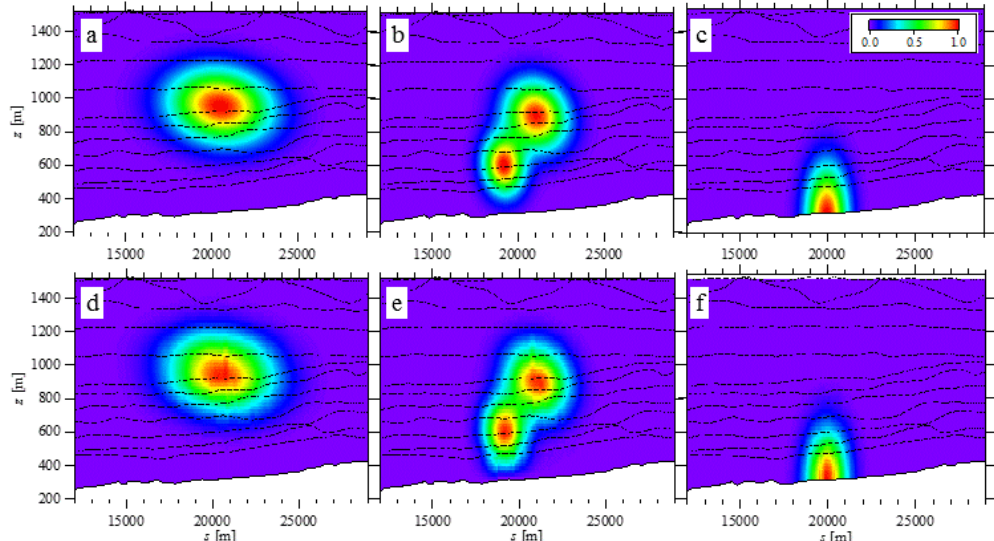
Figure 3. (a–c) The simulated emissions scenarios of Table 3 and Eq. (13) with the flight positions of the 20 August flight (black dots) for (a) an elevated source, (b) two elevated sources, and (c) a ground source. The values at the flight positions are then used with IDW, natural- neighbour, and kriging interpolation to attempt to recreate the original plume image. Resulting kriging-interpolated images (d–f) are shown for each scenario with (d) zero extrapolation, (e) zero-constant extrapolation, and (f) exponential fitting extrapolation below the lowest flight path. Table 3. Parameters used in Eq. (13) for each simulation scenario and plume number ( i) . The corresponding panel (a, b, or c) in Fig. 3 is also given. Fig.